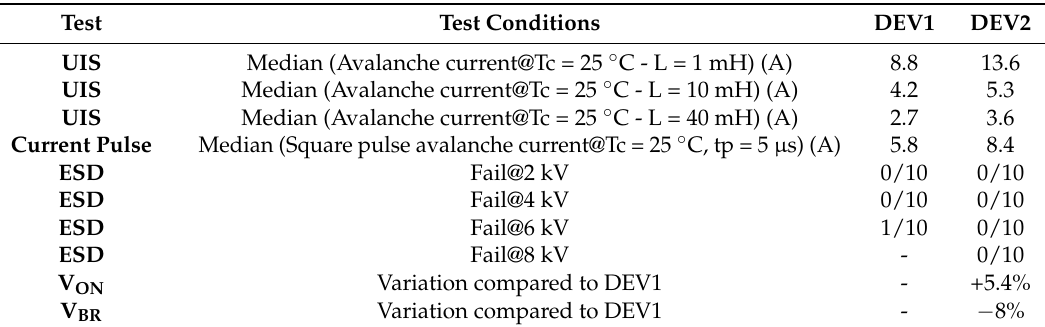
Figure 14. Comparison between the experimental I-V curves in forward conduction of the old design (DEV1) and the new design (DEV2) for T = 25 ◦ C and T = 125 ◦ C. Table 1. Performance summary of the two